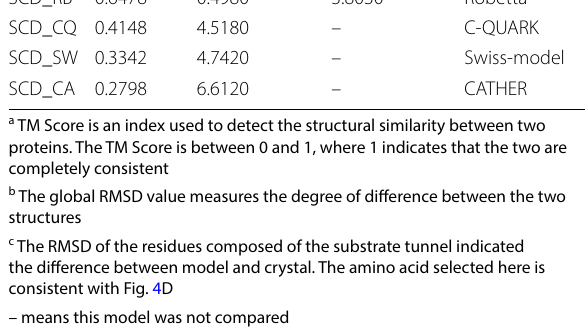
Table 1 Evaluation of the overall difference between the constructed model and the crystal structure of muSCD1